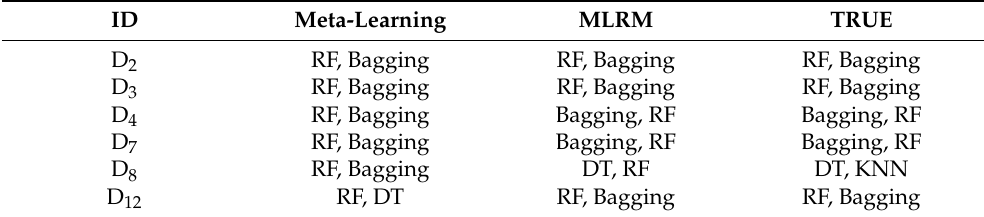
Table 10. Recommendation results between MLRM and meta-learning in septenaries.